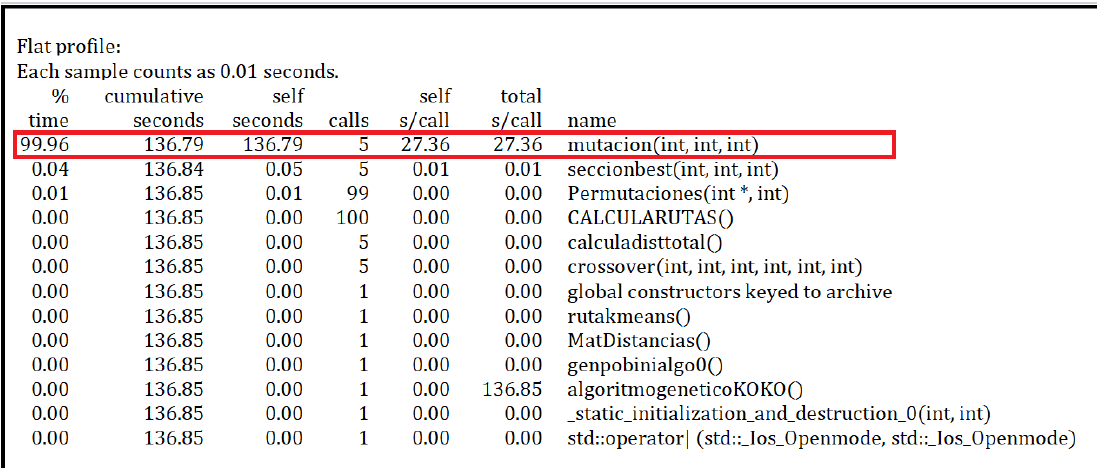
Figure 4. Performance analysis of the methods in the GA-VRPTW algorithm [1].